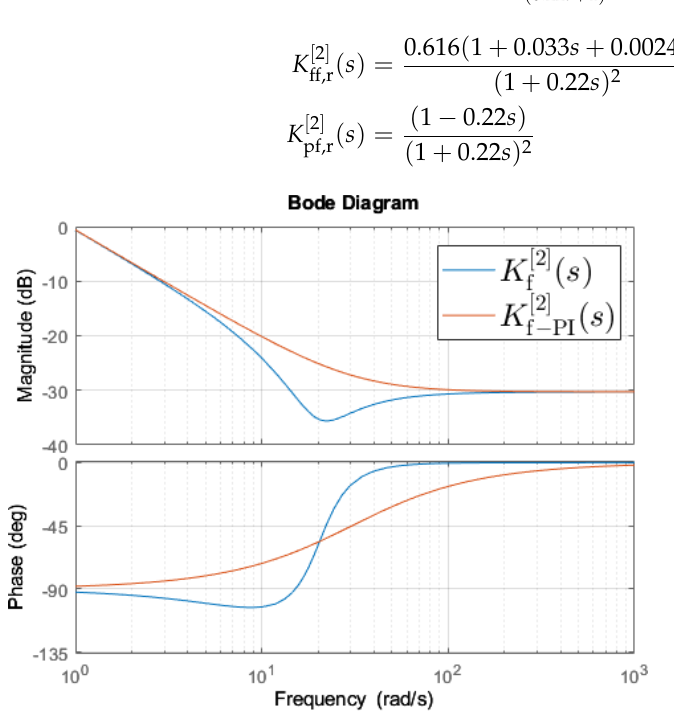
Figure 13. Inner loop feedback controller (and its